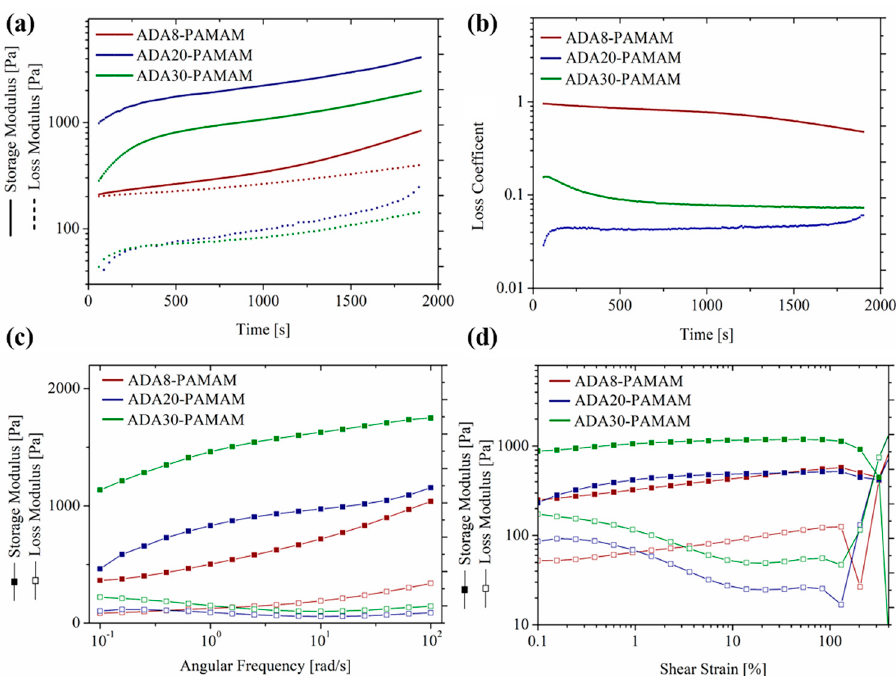
Figure 4. Rheology test results of ADA8-PAMAM, ADA20-PAMAM and ADA30-PAMAM, respec- tively. The modulus and loss coefficient results of the time sweep test are shown in ( a , b ), respectively. ( c ) refers to the frequency sweep test and ( d ) presents amplitude sweep test results.